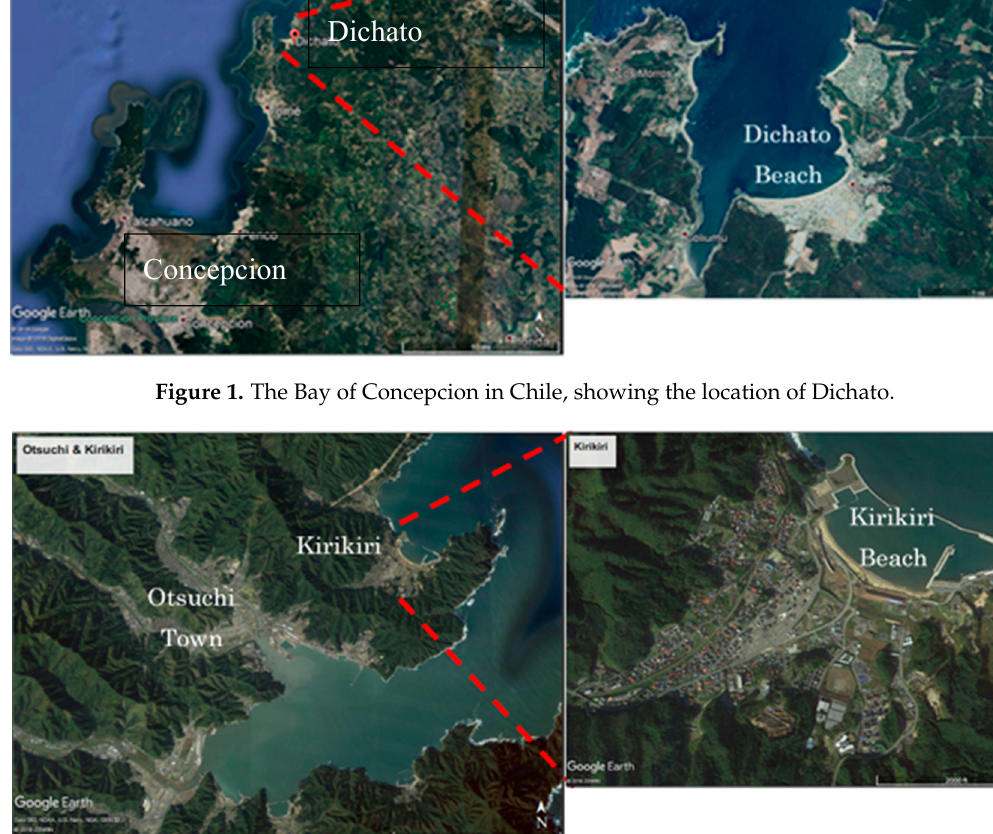
Figure 2. Otsuchi Bay in Japan, showing the location of Kirikiri.